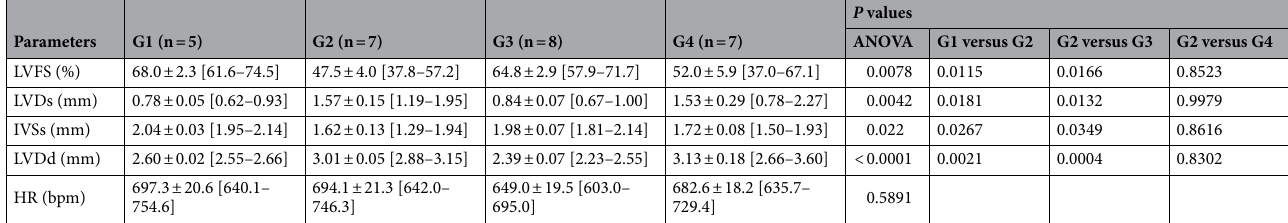
Table 4. Echocardiographic data on day 56 in experimental autoimmune myocarditis (EAM) mice. Data are mean ± SEM [95% confidence interval]. Echocardiographic findings on day 56 in non-EAM mice treated daily with vehicle only (G1: n = 5) or in EAM mice treated daily with vehicle (G2: n = 7), selective prostaglandin E2 receptor 4 (EP4) agonist (ONO-0260164) (G3: n = 8), or both ONO-0260164 and selective EP4 antagonist (CJ-42794) (G4: n = 7) from day 14 to day 56. P values were calculated with 2-way ANOVA followed by the Bonferroni-Dunn post hoc testing method. LVFS Left ventricular fractional shortening, LVDs LV end-systolic dimension, IVSs Interventricular septum systolic thickness, LVDd LV end-diastolic dimension, HR Heart